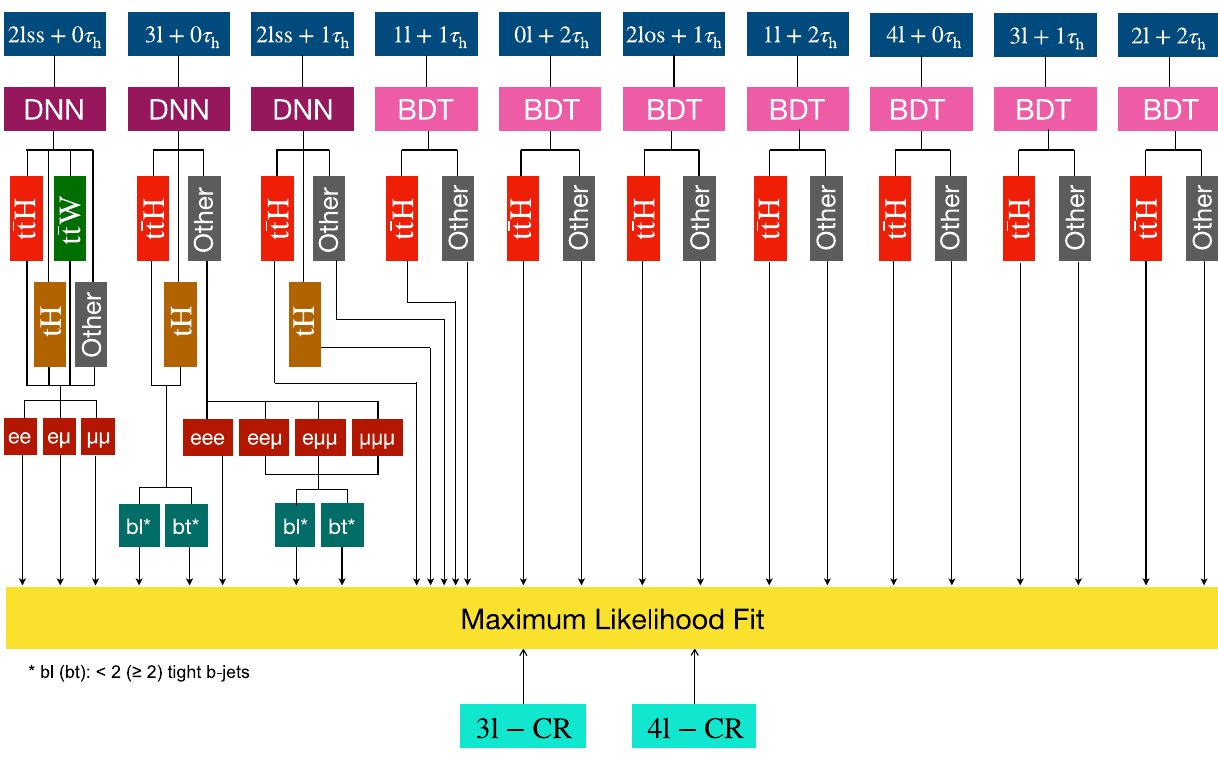
Fig. 3 Diagram showing the categorization strategy used for the signal extraction, making use of MVA-based algorithms and topological variables. In addition to the ten channels, the ML fit receives input from two control regions (CRs) defined in Sect.